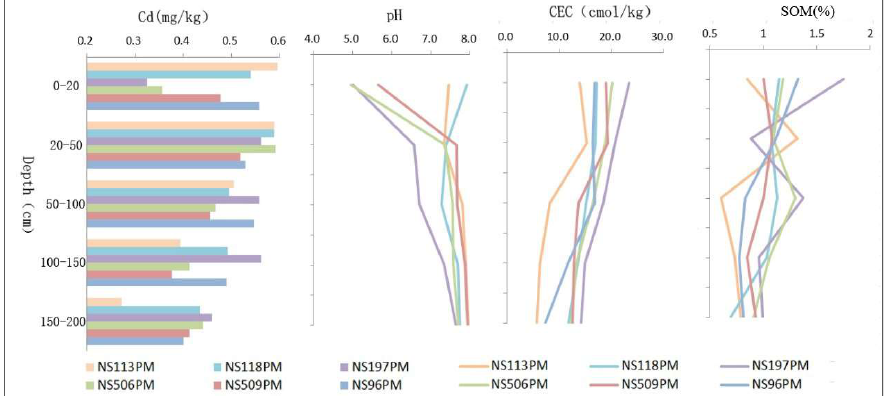
Figure 2. Comparisons between Cd, pH, cation exchange capacity (CEC), and soil organic matter (SOM) for the different depths and soil profiles.